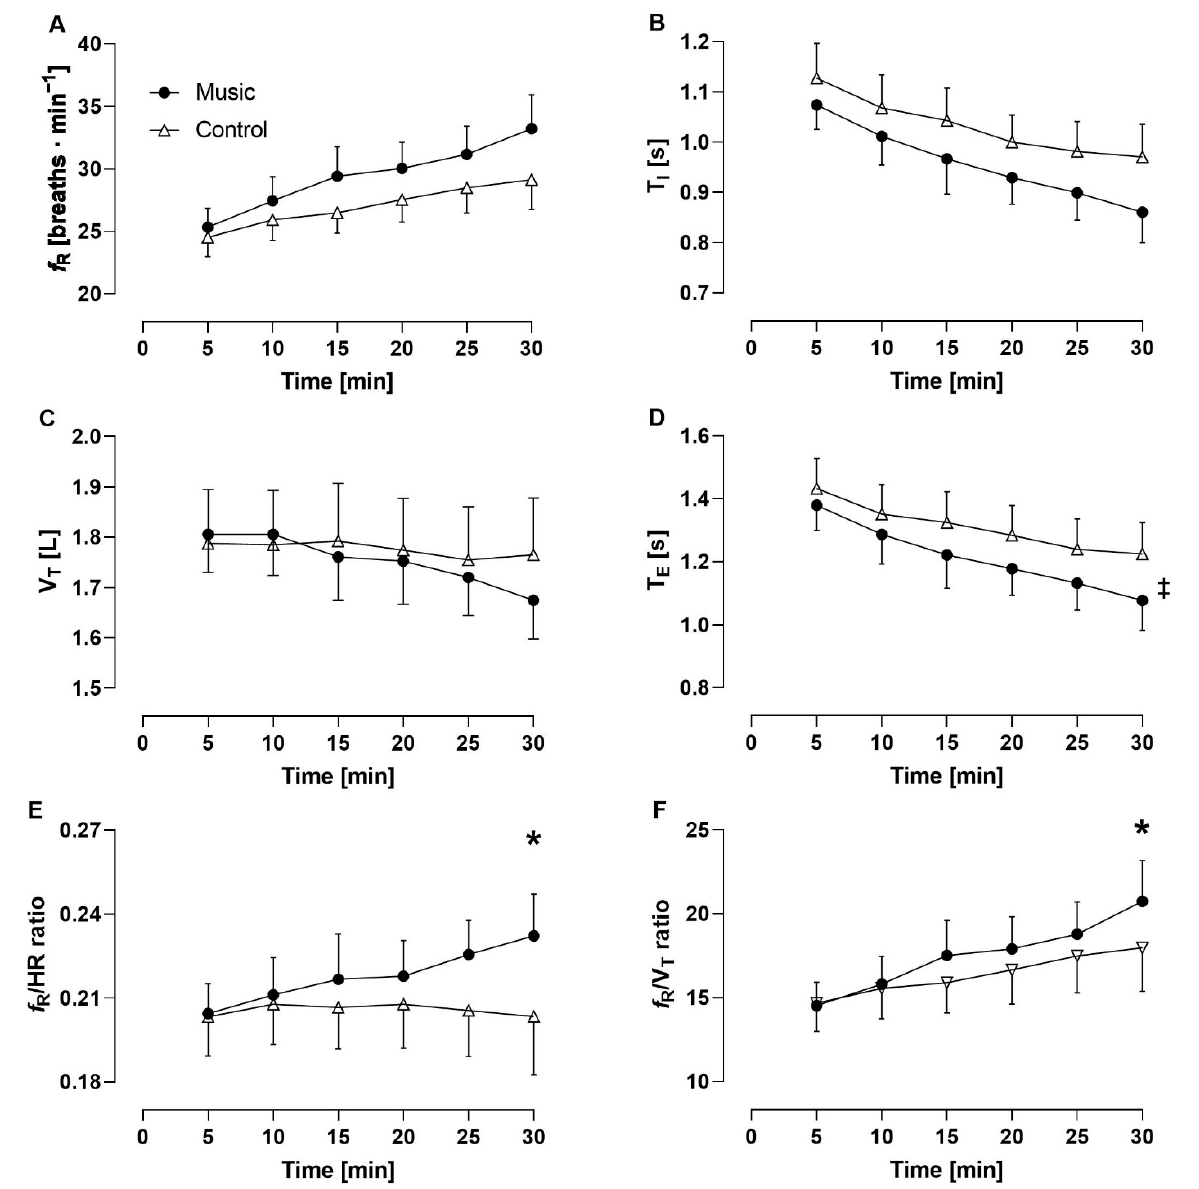
Figure 6. Time course of respiratory frequency ( A ), inspiratory time ( B ), tidal volume ( C ), expiratory time ( D ), f R /HR ratio ( E ), and f R /V T ratio ( F ) for the music condition (filled circles) and the control condition (open triangles). ‡ main effect of condition ( p < 0.05); * p < 0.05 vs. control condition. When comparing the Latin music with its own control condition at the three levels of music tempo, no significant condition × music tempo interaction nor main effect of condition were found for f R , T I , V E , V T , pedaling cadence, perceived exertion, affective valence, and perceived arousal while a statistical trend was found for the main effect of condition for T E ( p = 0.085; η p2 = 0.227). A comparison with data from previous studies is provided in Table